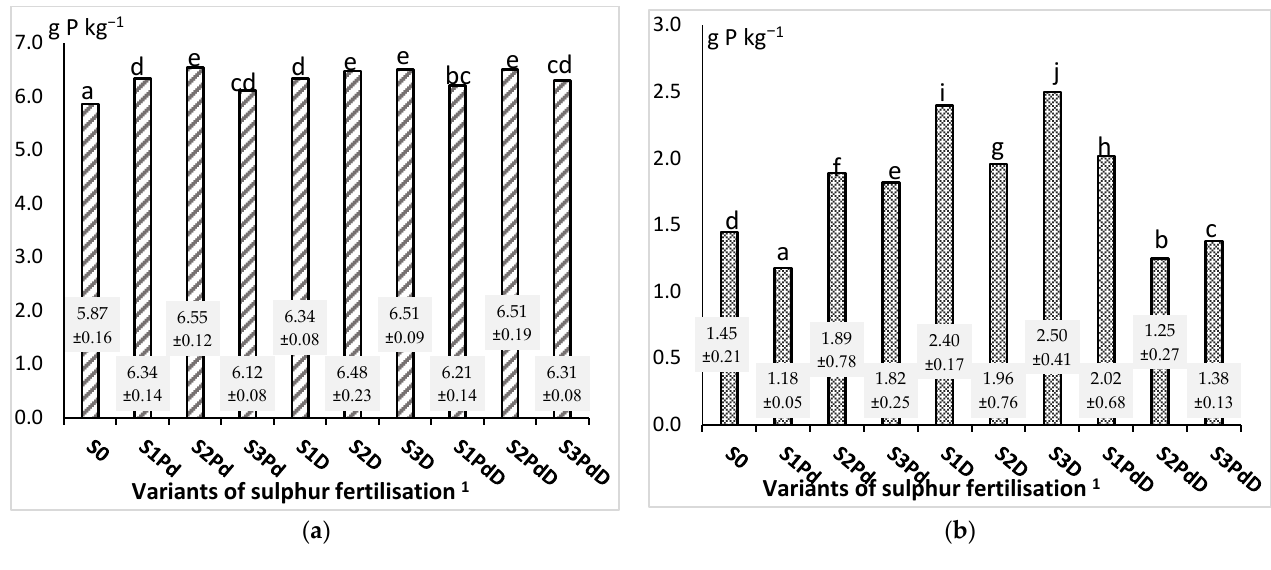
Figure 7. ( a ) Phosphorus content in the rape seeds on average for variants of sulphur fertilisation; ( b ) Phosphorus content in the rape straw on average for variants of sulphur fertilisation. 1 See Table 2; Means followed by the same letter are not statistically different at the α = 0.05 level. ± —standard deviation.